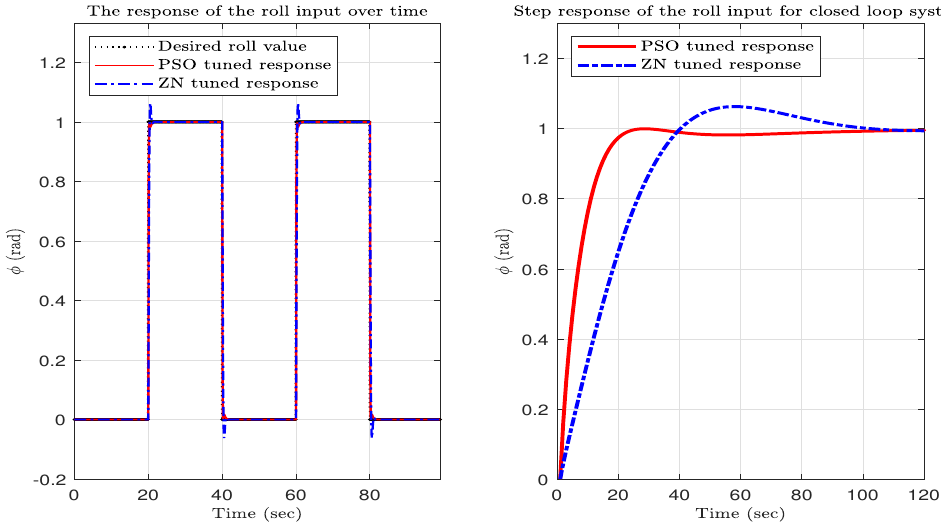
Figure 11. Simulated output responses of the roll input of a quadcopter using PSO and ZN